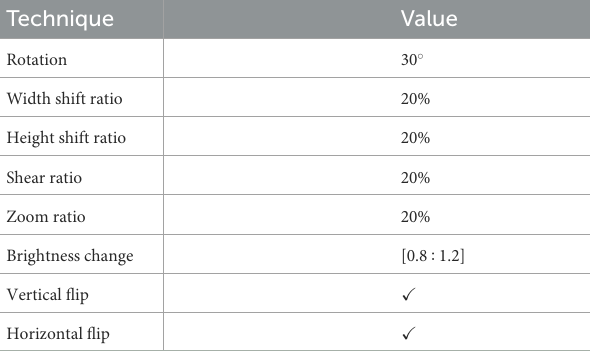
TABLE 4 The solution indexing and the corresponding